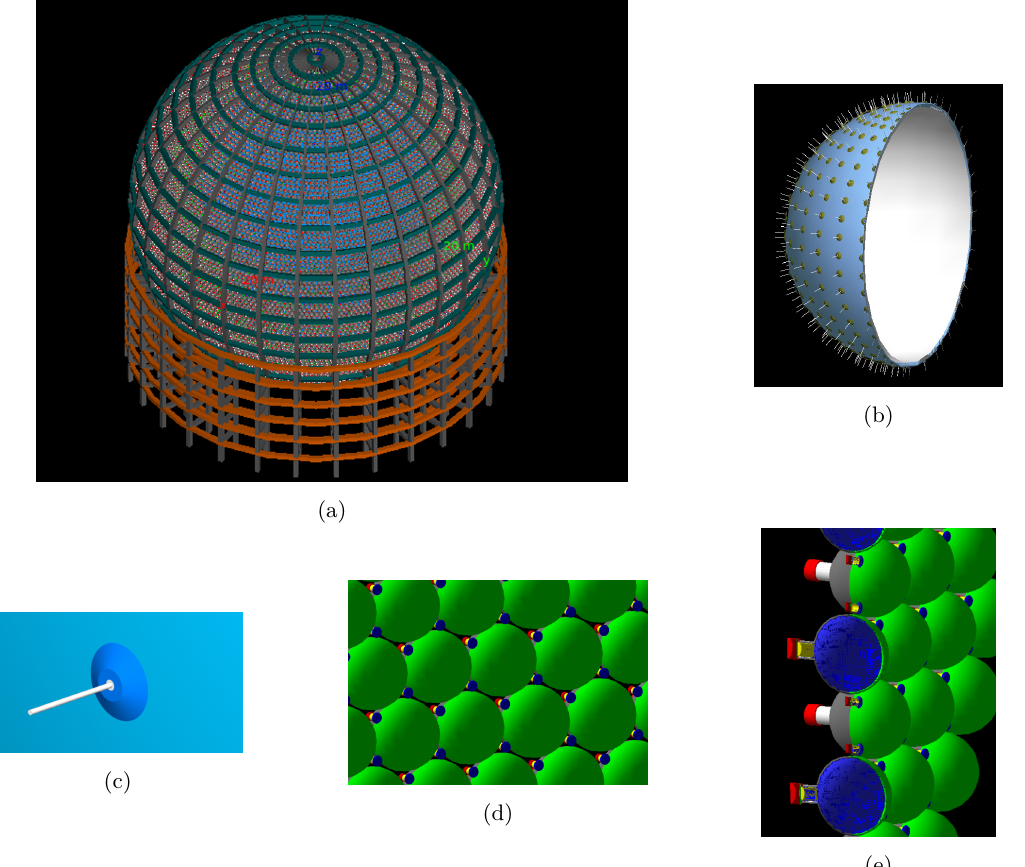
Figure 12. Details of the JUNO experimental setup as reconstructed by the ARBY simulation code: a) SS truss supporting the PMTs and the acrylic sphere; b) Acrylic sphere containing the LS with bars on the outside for the connection to the steel truss; c) Acrylic node and supporting SS bar; d) Large and Small PMT systems; e) sections of the LPMTs showing potting